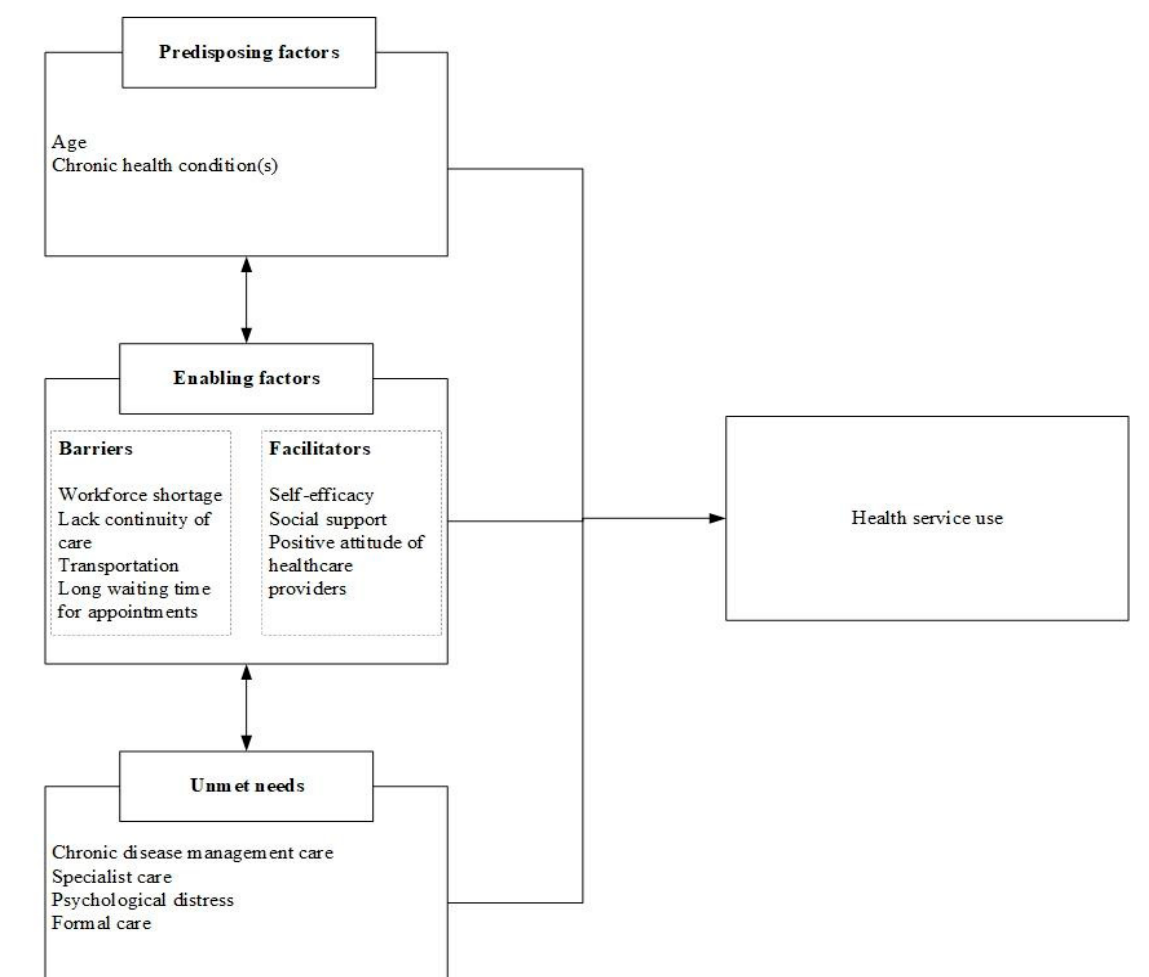
Figure 1. Unmet healthcare needs and factors of older adults’ health services use.